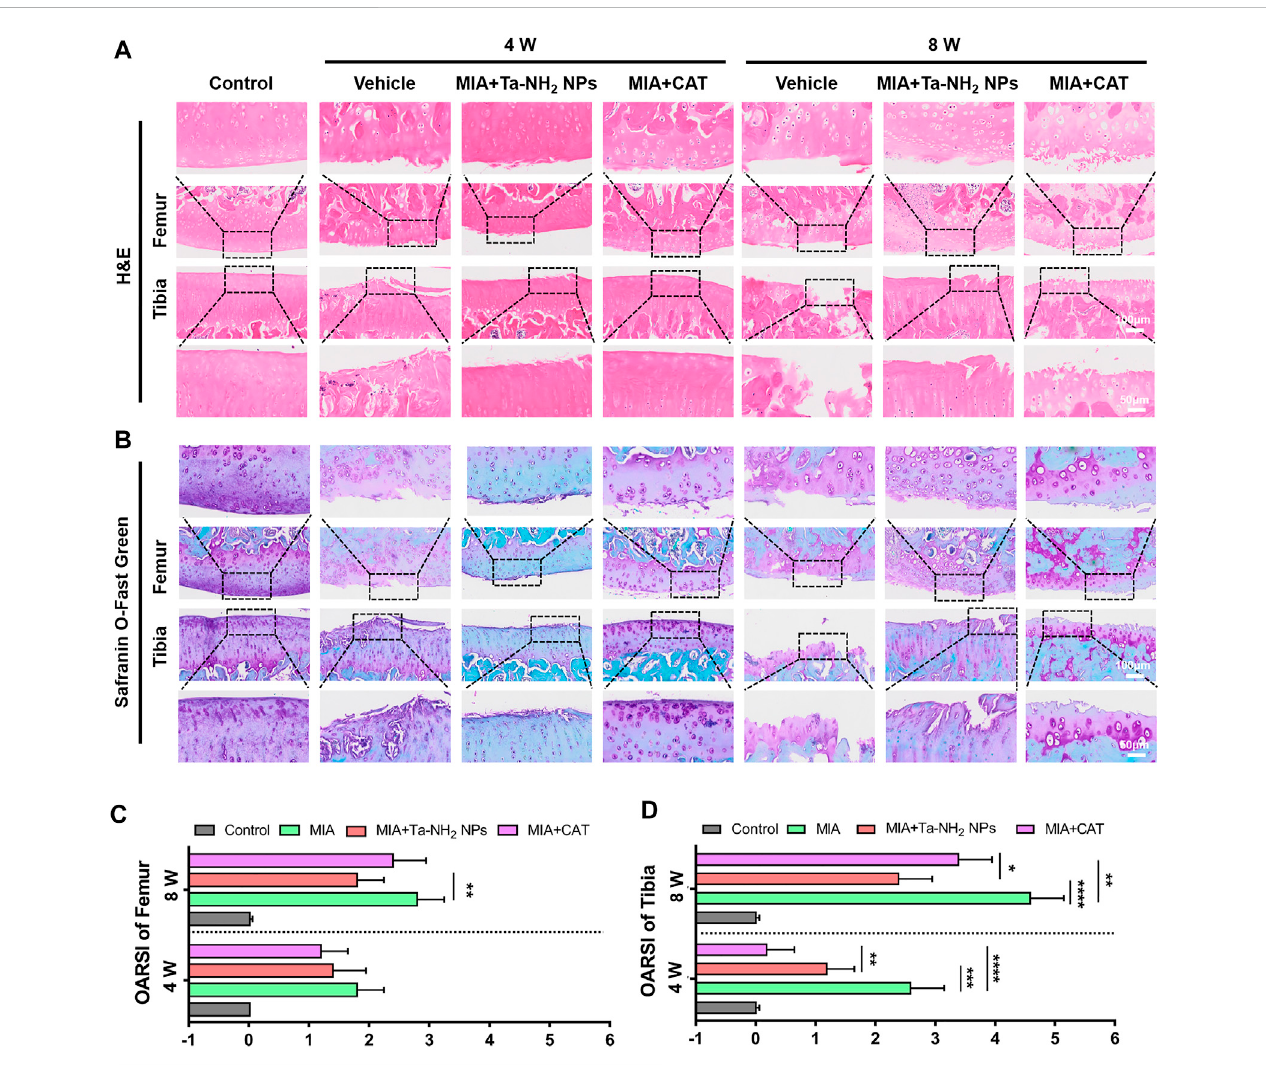
FIGURE 8 Therapeutic ef fi ciency of Ta-NH 2 NPs on MIA-induced OA. (A) H&E staining and (B) Safranin-O-Fast Green Staining of articular joints from each group. The box marked local magni fi cation. OARSI score of (C) femur and (D) tibia at 4 and 8 weeks post treatments. Data were represented as means ± s.d., from fi ve independent replicates (One-way ANOVA), * p < 0.05, ** p < 0.01, *** p < 0.001, **** p <